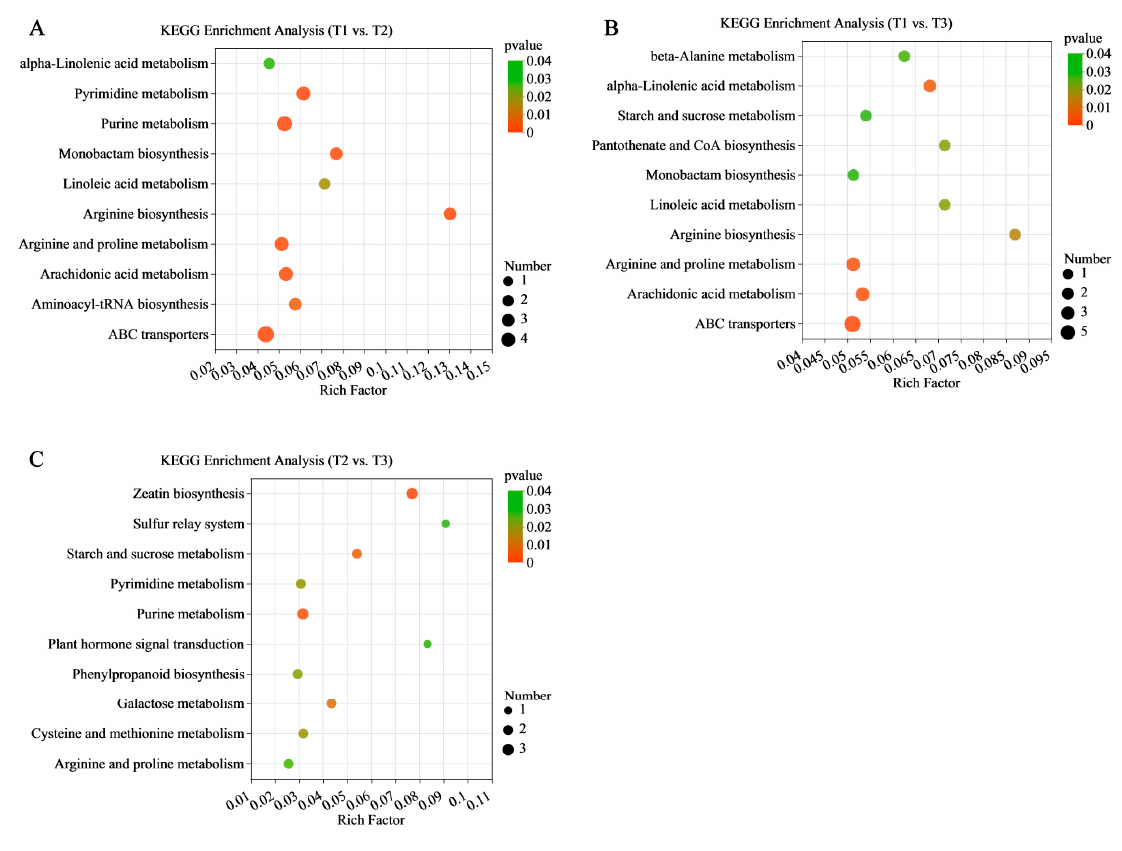
Figure 8. KEGG analysis of DEMs in ( A ) T1 vs. T2, ( B ) T1 vs. T3, ( C ) and T2 vs. T3. The x -axis represents the richness factor and the y-axis shows KEGG pathways. The color and size of the dots represent the p -value and the number of enriched differential metabolites, respectively. Rich factor means the ratio of the number of differential metabolites to the total number of metabolites enriched in a specific category.